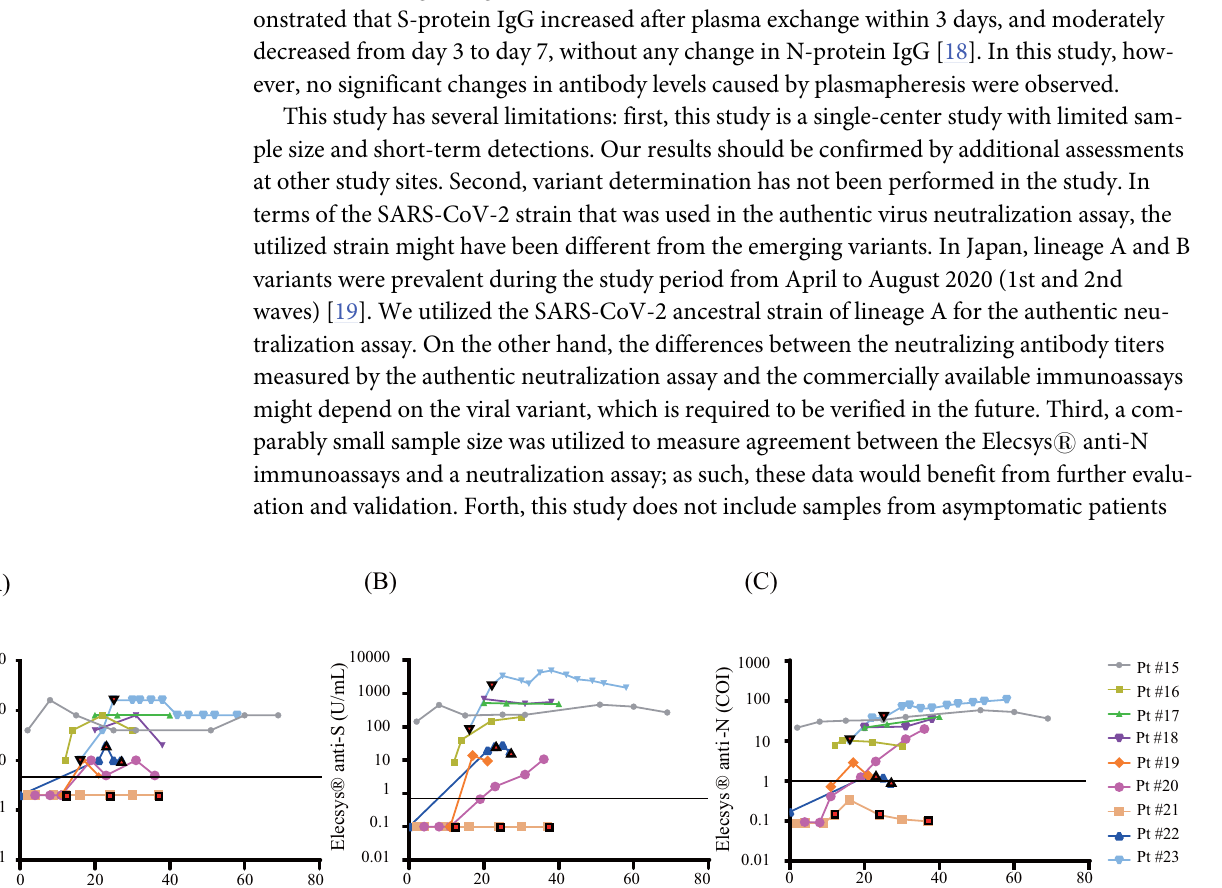
PLOS ONE | https://doi.org/10.1371/journal.pone.0274181 September 15,